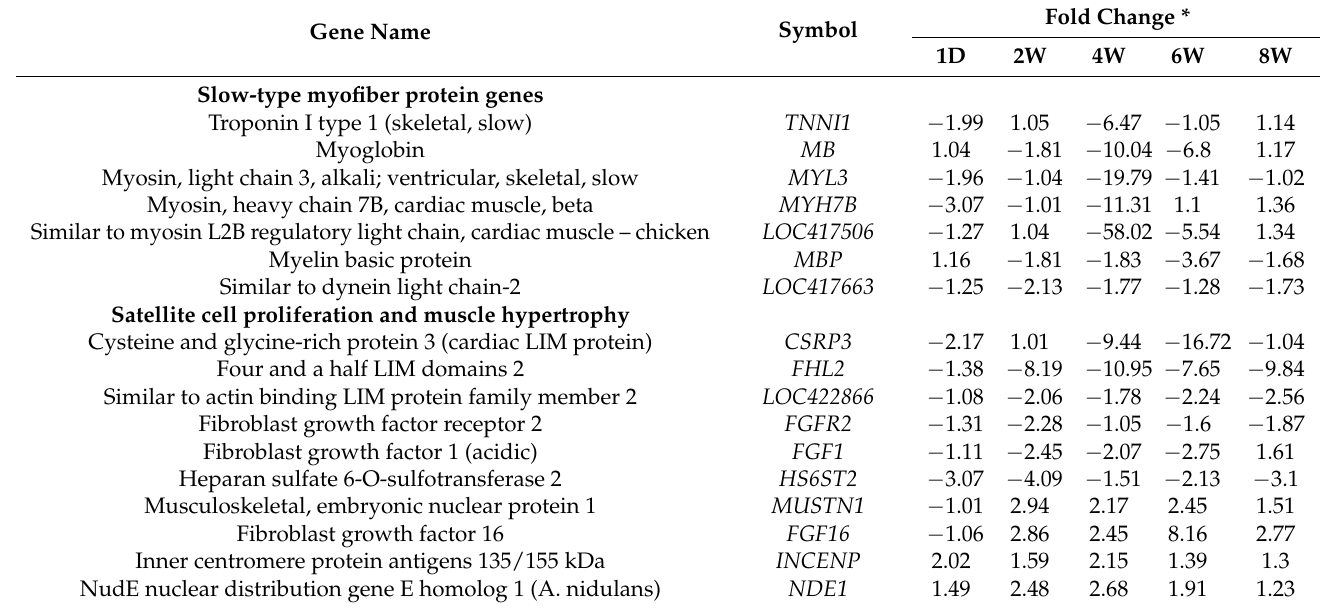
Table 1. Genes associated with muscle growth in broiler and layer